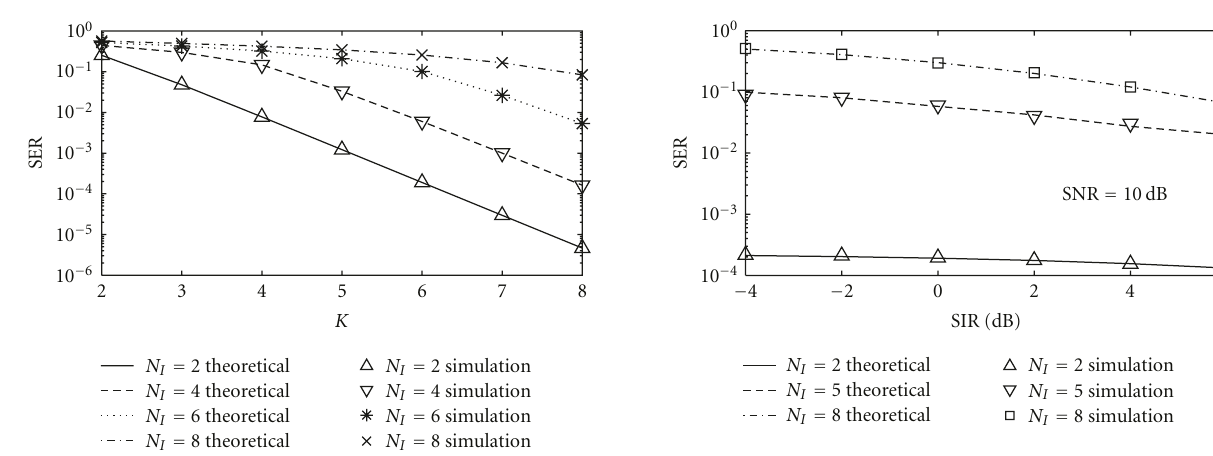
Figure 5: SER versus SIR with di ff erent values of N I when L = 4, K = 6, QPSK interferers.